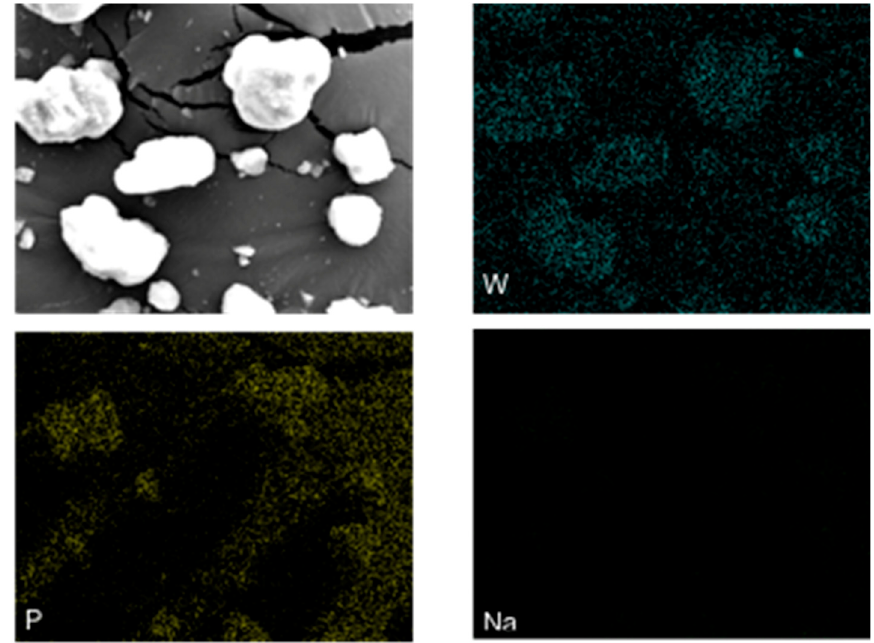
Figure 7. SEM micrographs of H 14 NaP 5 W 30 O 110 /Catalox SBa-90, mapping of W, P, and Na.